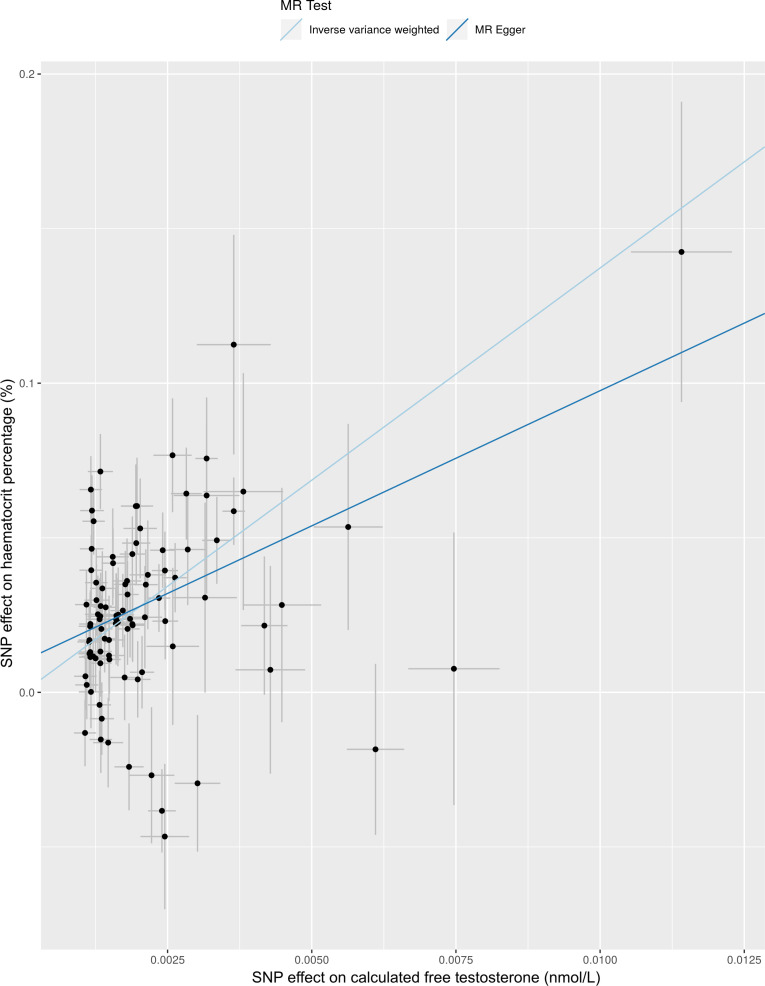
Comparison of effect of calculated free testosterone on hematocrit percentage using Mendelian randomization with IVW and Egger regression methods.